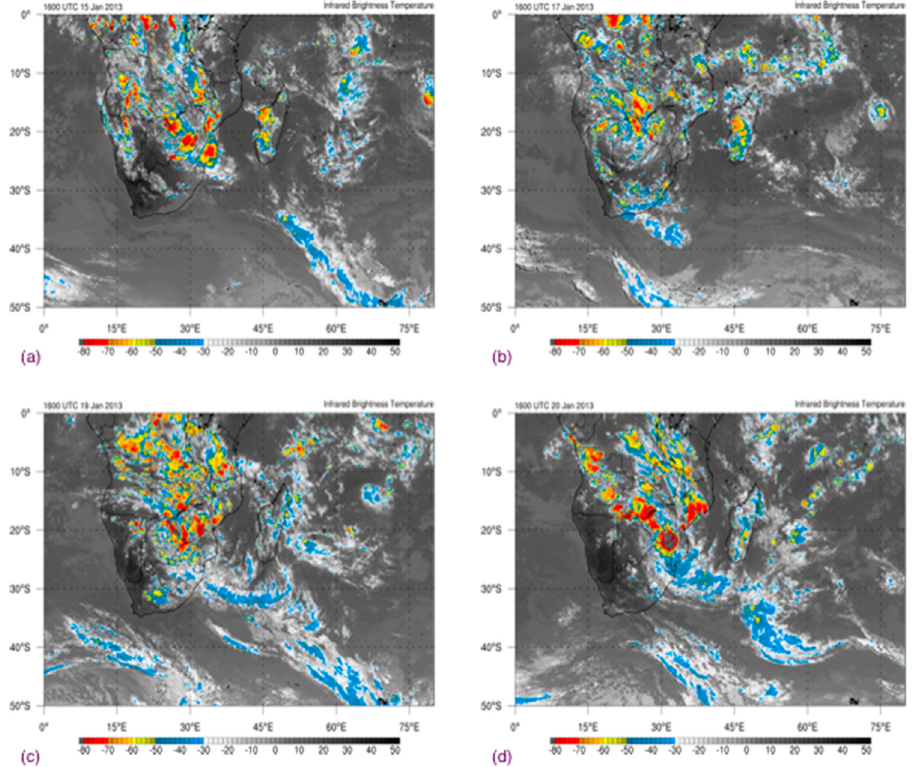
Figure 8. Infrared (IR) brightness temperature ( ◦ C) (http: // www.atmos.albany.edu / student / ppapin / Figure 8 . Infrared (IR) brightness temperature ( ° C) mapdisco / 20130201 / images / ir_africa.html). Infrared brightness temperature over southern Africa on 15 (http://www.atmos.albany.edu/student/ppapin/mapdisco/20130201/images/ir_africa.html). Infrared ( a ), 17 ( b ), 19 ( c ) and 20 ( d ) January brightness temperature over southern Africa on 15 ( a ), 17 ( b ), 19 ( c ) and 20 ( d ) January 2013.